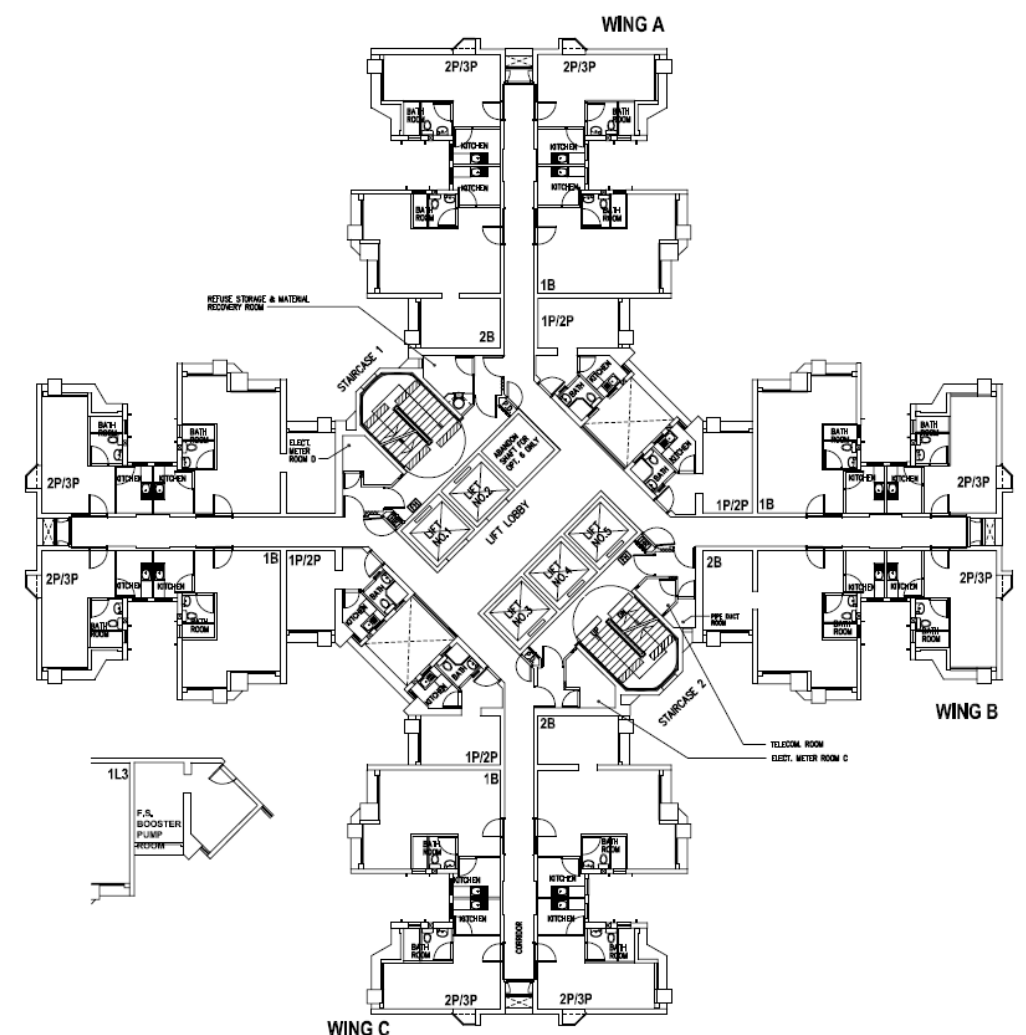
Figure 2. New Harmony One (NH1) residential building design.